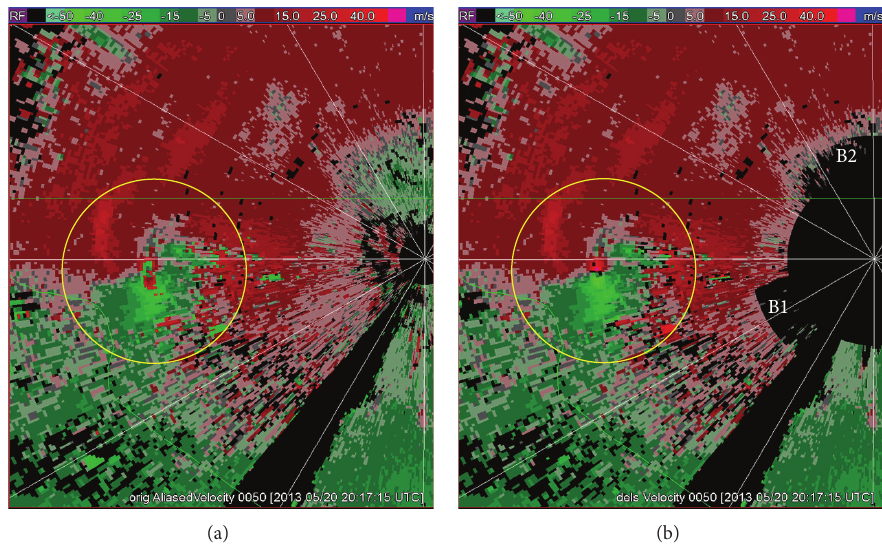
Figure 6: Enlarged displays around the mesocyclone of (a) the raw radial-velocity image in Figure 5(a) and (b) the dealiased radial-velocity image in Figure 5(c). The yellow circle in each panel encircles the mesocyclone. The white letters B1 and B2 in panel (b) mark the two flagged (in black) areas immediately outside the 5km range, while the radial velocities within the 5km radial range on 0.5 ∘ tilt are not used and thus flagged (in black) to avoid possible ground clutter